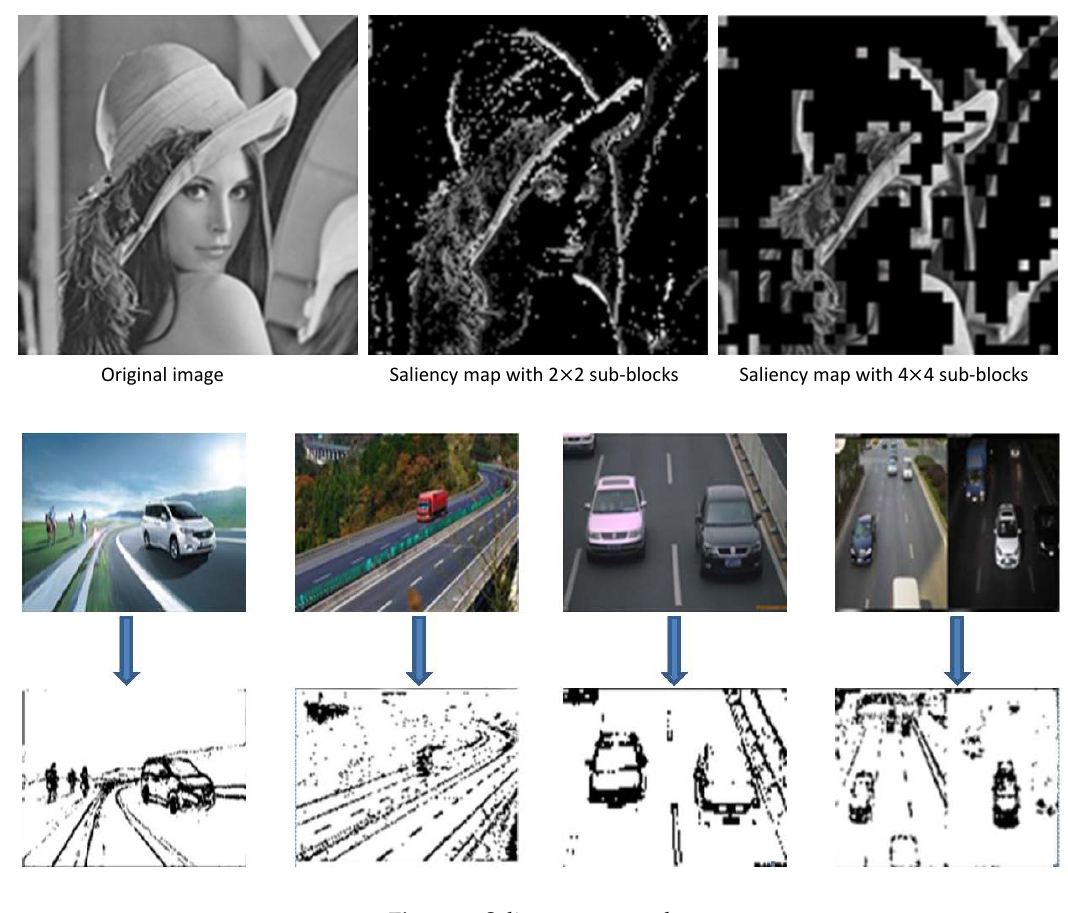
Figure 6. Saliency map